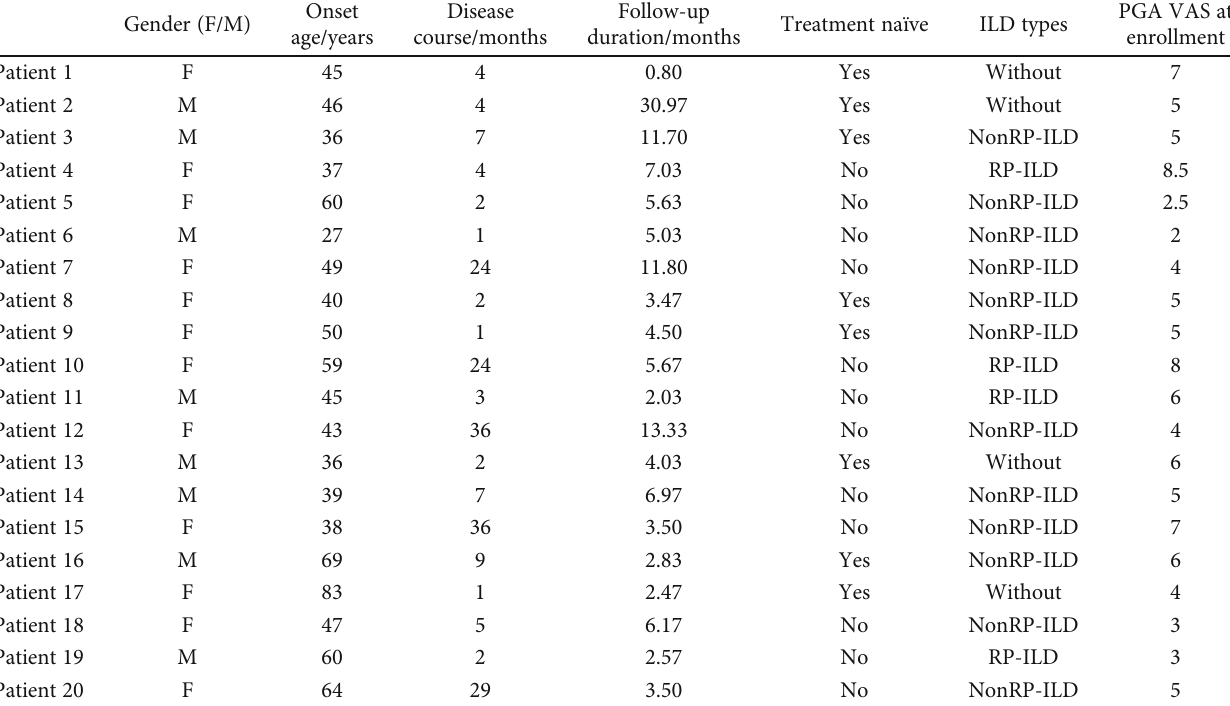
Table 3: Basic clinical characteristics of DM patients with follow-up